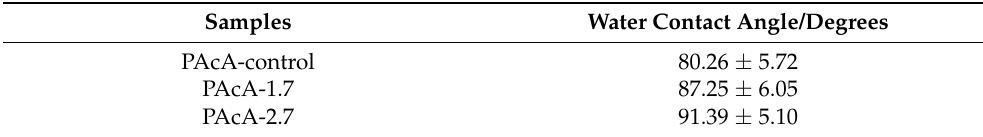
Table 4. Water contact angle measurements (average ± standard deviation) for control and hybrid samples of PCL.